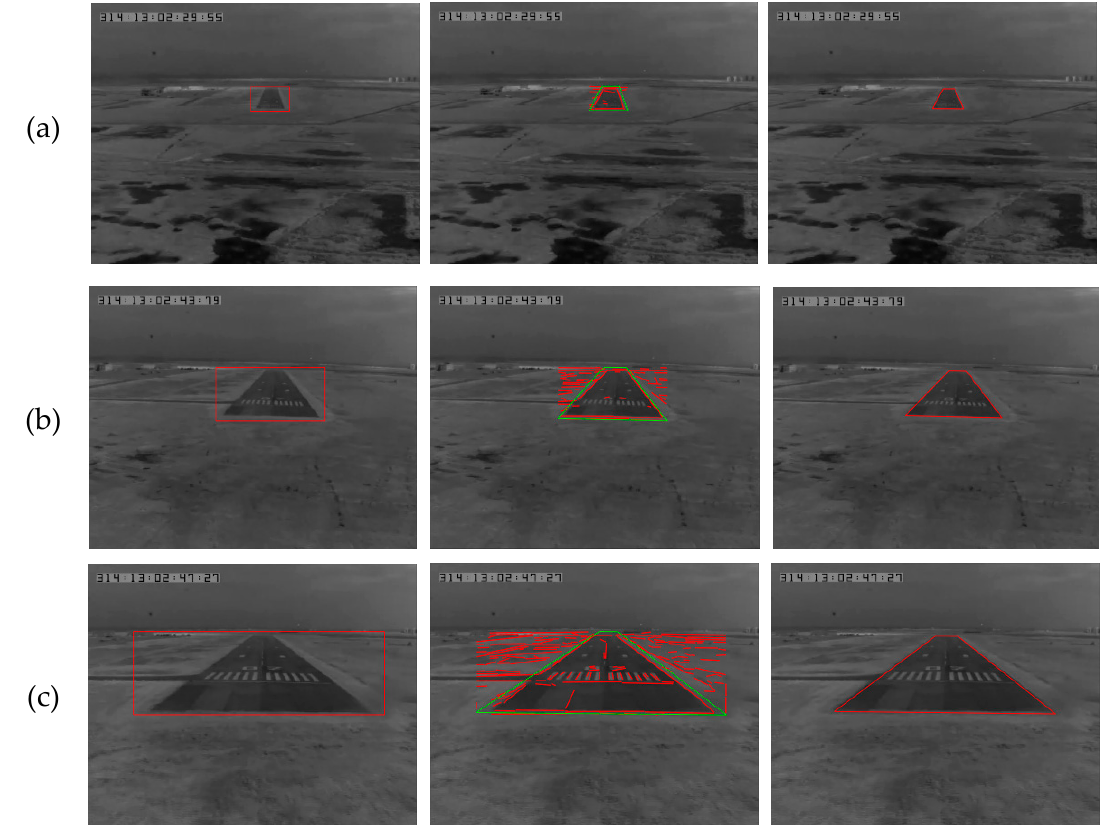
Figure 10. Runway detection at typical flight height: ( a ) 200 ft; ( b ) 100 ft; ( c ) 60 ft.